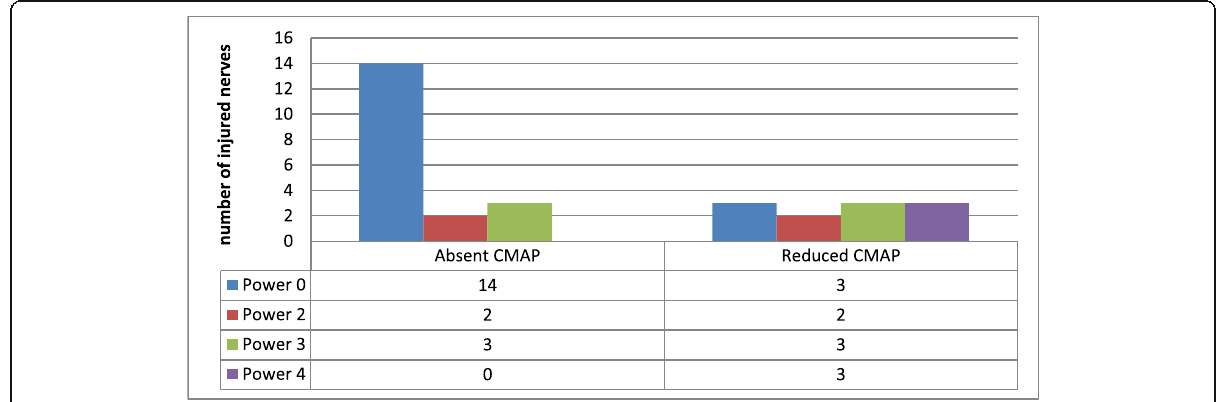
Fig. 1 Relationship between compound muscle action potential amplitude and power of the supplied